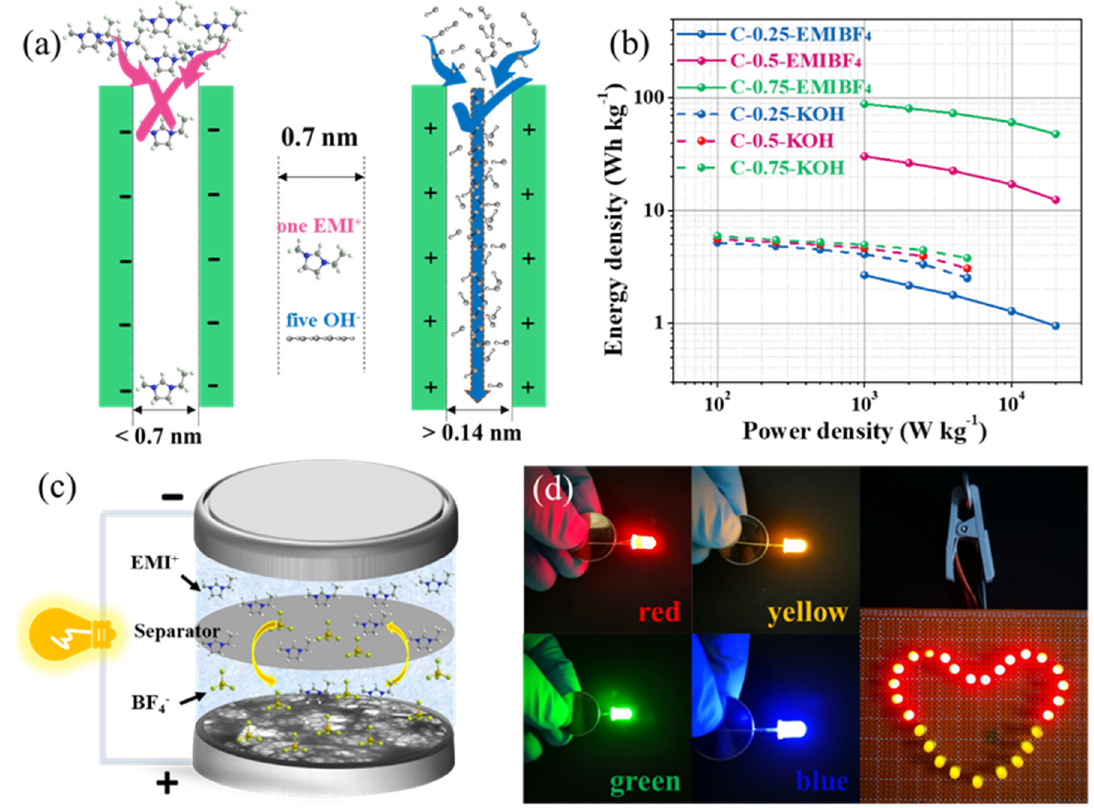
Figure 9. ( a ) Proposed pore-dependent ion diffusion models using two kinds of electrolytes (KOH and EMIBF 4 ) with different ion sizes. ( b ) The Ragone plot shows the energy–power density relationship of the two-electrode symmetric capacitor used in different electrolytes. ( c ) Illustration of the assembled 4 V coin cell using C-0.75 as the electrode material, and ( d ) its practical demonstration in lighting LEDs with different colors and working voltages, or in parallel.